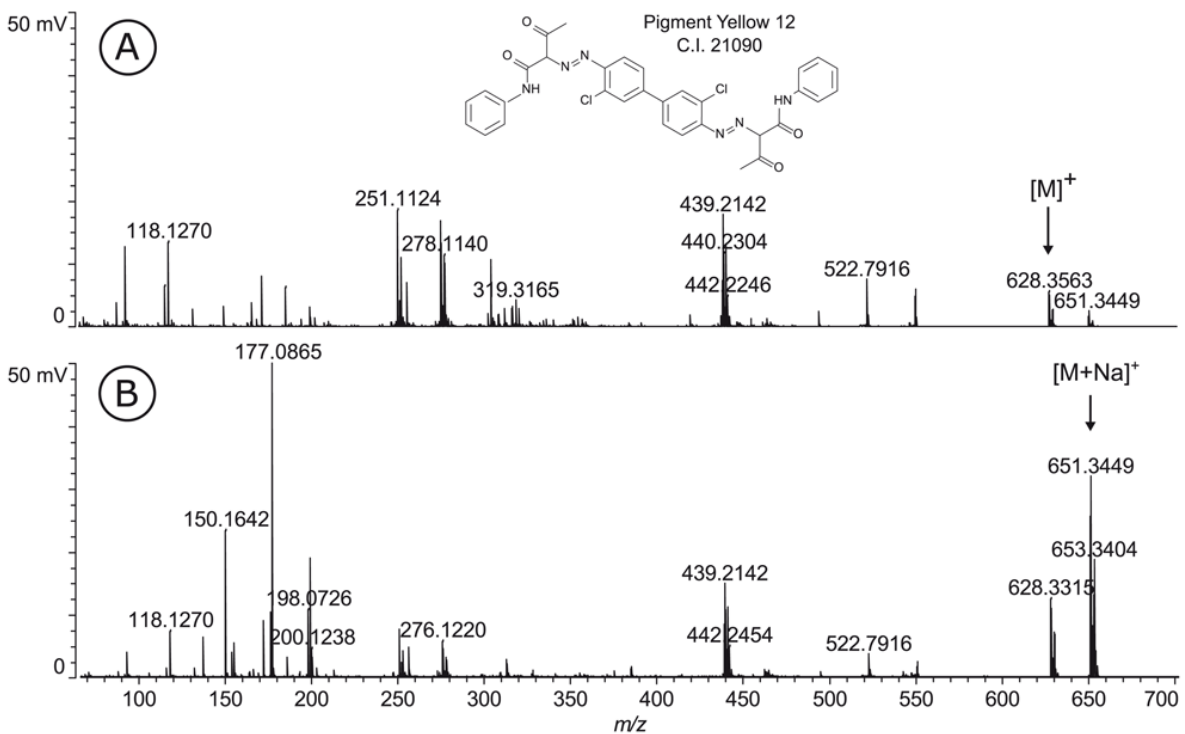
Figure 4. LDI mass spectra of pigment Yellow 12 (C.I. 21090) without matrix ( A ) and MALDI spectra of the same pigment with DHB as a matrix ( B ).